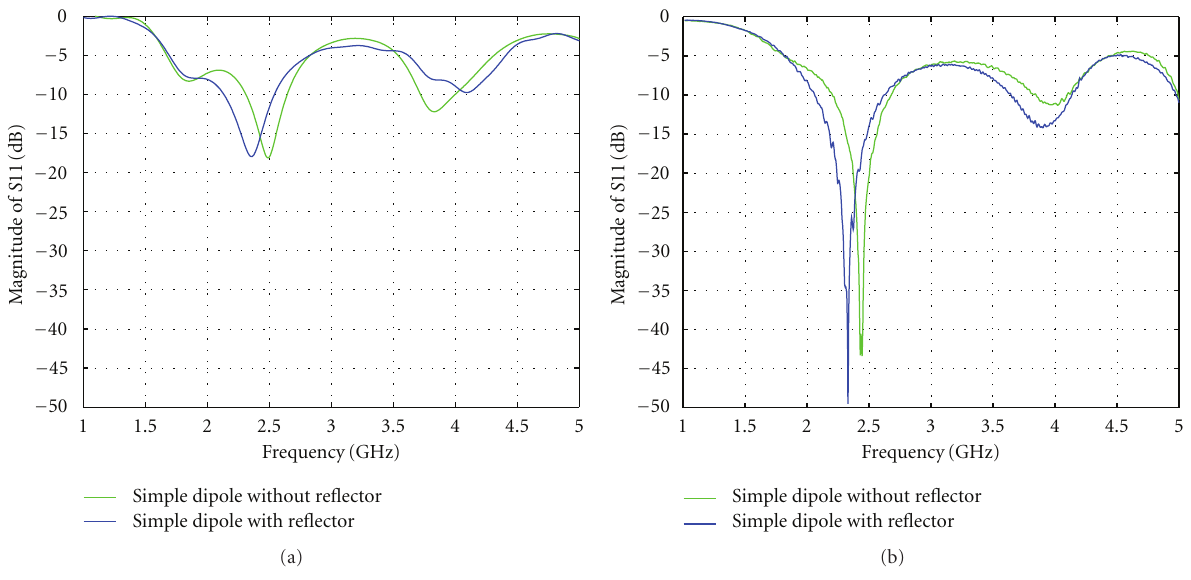
Figure 8: S 11 parameter of dipole structure with and without reflector: (a) simulated and (b) measured.